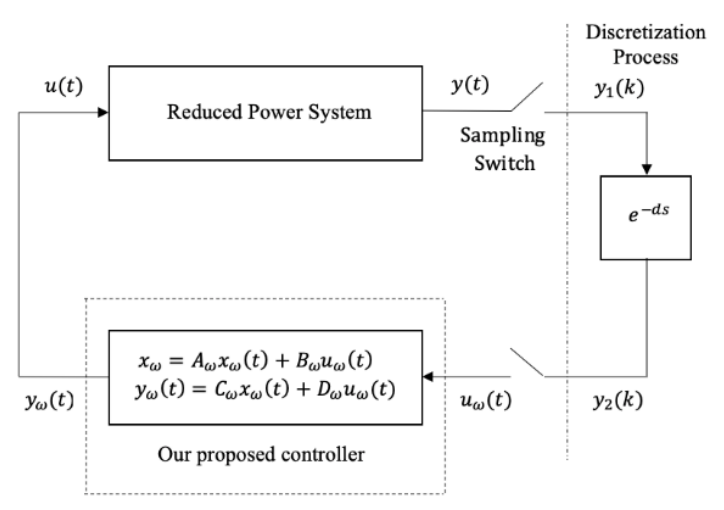
Figure 1. The structure of the augmented closed-loop power system.